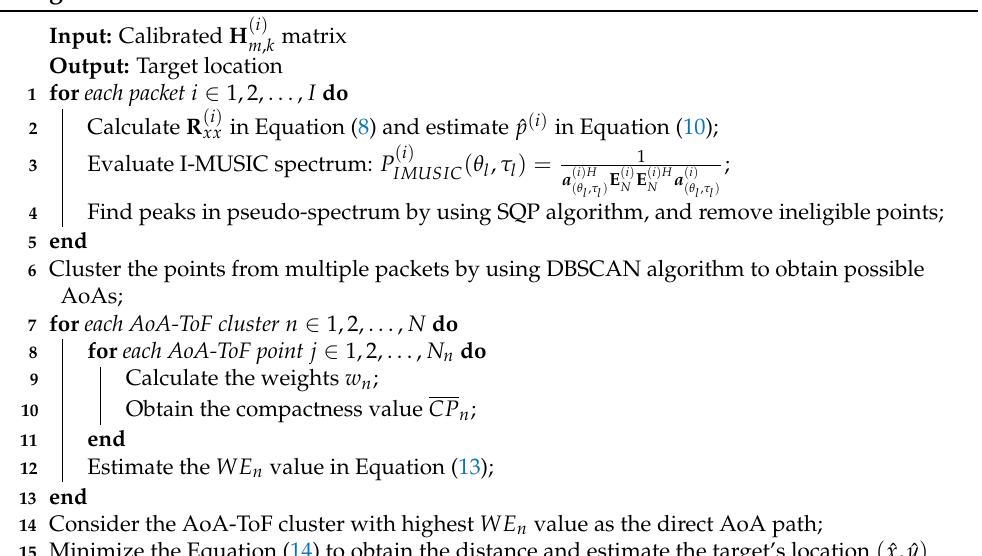
Algorithm 2: AoA Estimation and